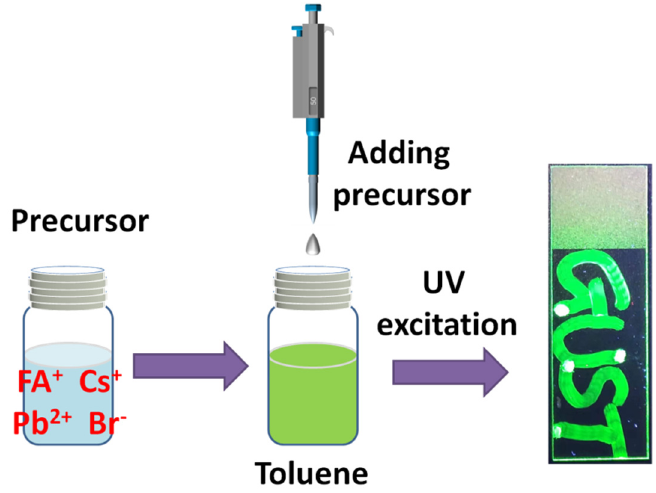
Figure 1. Schematic diagram of synthesis process of perovskite QDs.